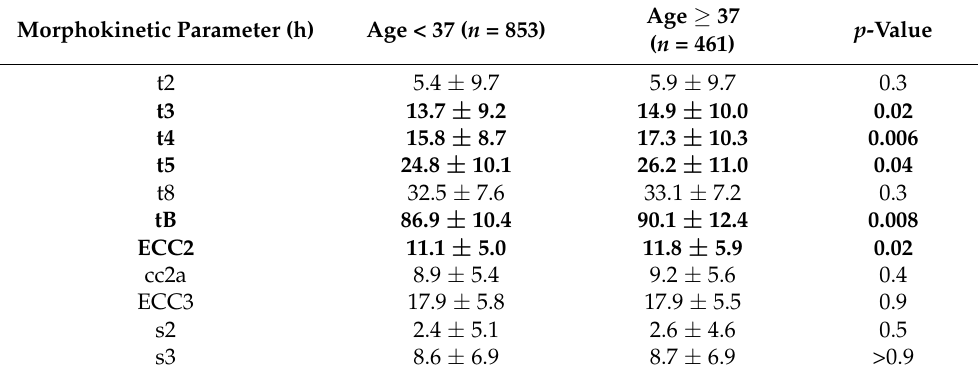
Table 4. Absolute and relative morphokinetic events of embryos in the two different age groups. Values are shown as mean ±